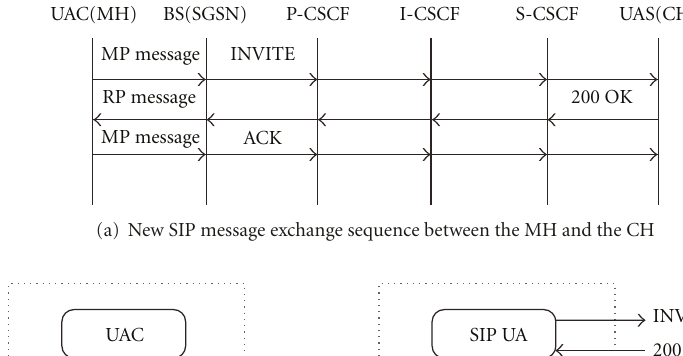
is, the proxy agent on the BS reestablishes the SIP session between the new BS and the CH using the stored S-SPEC on behalf of an MH. No change is required in the SIP message processing except for the proxy agents in both BS and